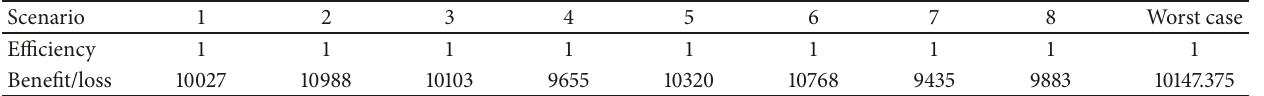
Table 9: Evaluating different scenarios for the Ideal DMU (Model RI a ).